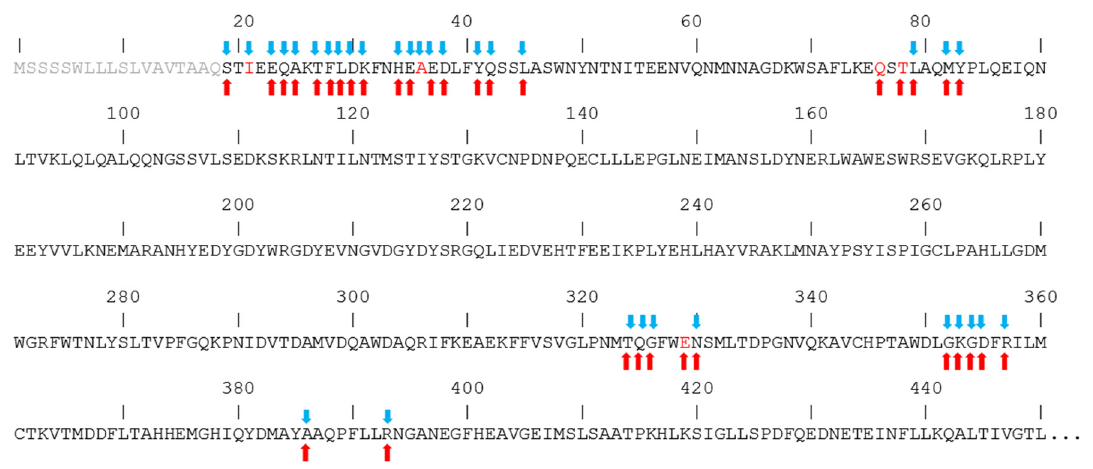
Figure 4. Interaction of hACE2 amino acids with the spikes of CoV-2 (blue arrows) and CoV-1 (red arrows). Amino acid letters in red indicate unique interaction. Segment 1–18 of the sequence is shown in grey because it is not present in the experimental structures.